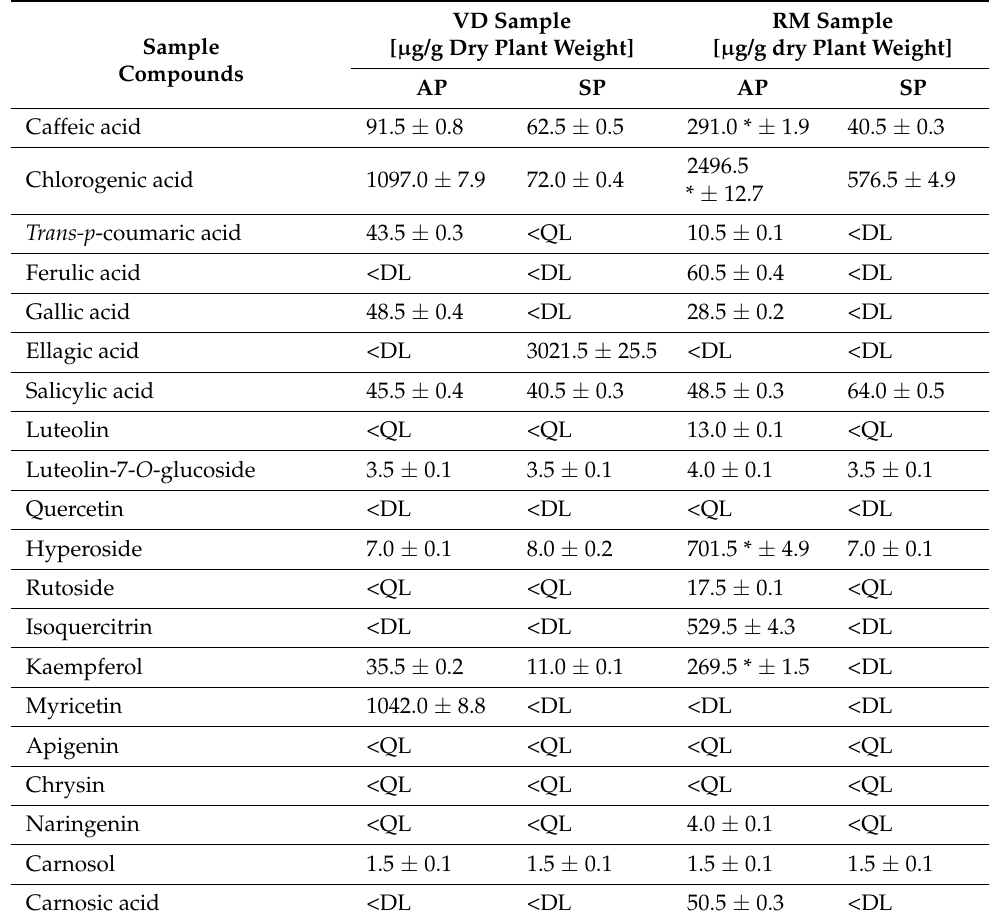
Table 1. Quantitative determination of polyphenols by LC/MS in the hydro-ethanolic extract of the aerial and subterranean parts of T. farfara , in accordance with the standard calibration curves for purified